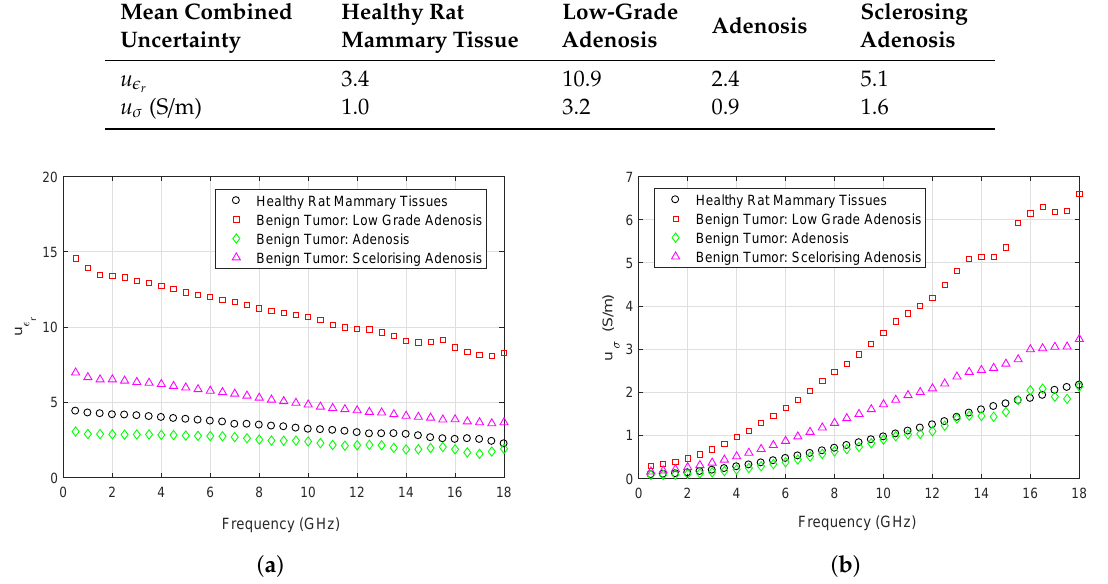
Figure 4. Calculated combined uncertainty values for rat mammary tissues: ( a ) Comparison of relative permittivity uncertainty calculations for benign tumor and healthy tissues; ( b ) Comparison of conductivity uncertainty calculations for benign tumor and healthy tissues.